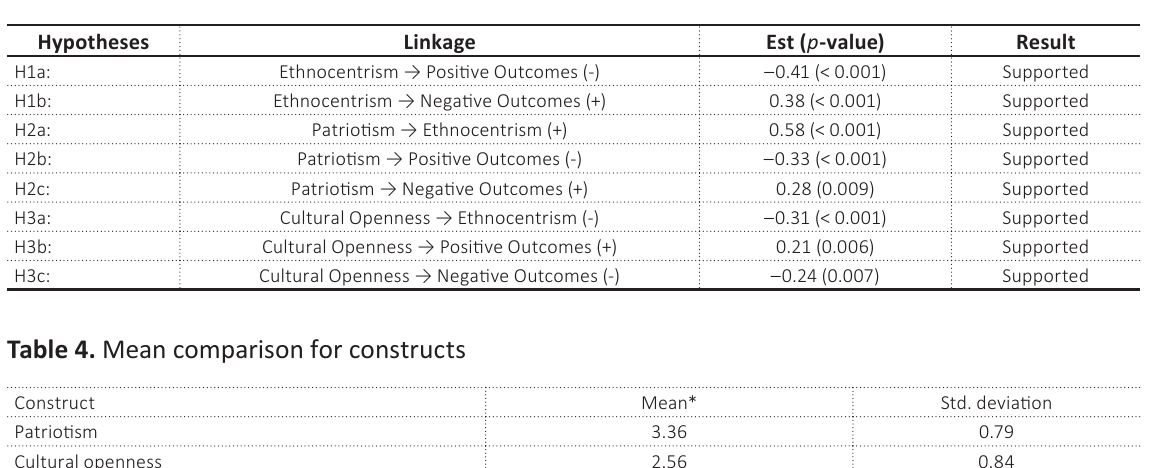
Table 3. Hypotheses testing results